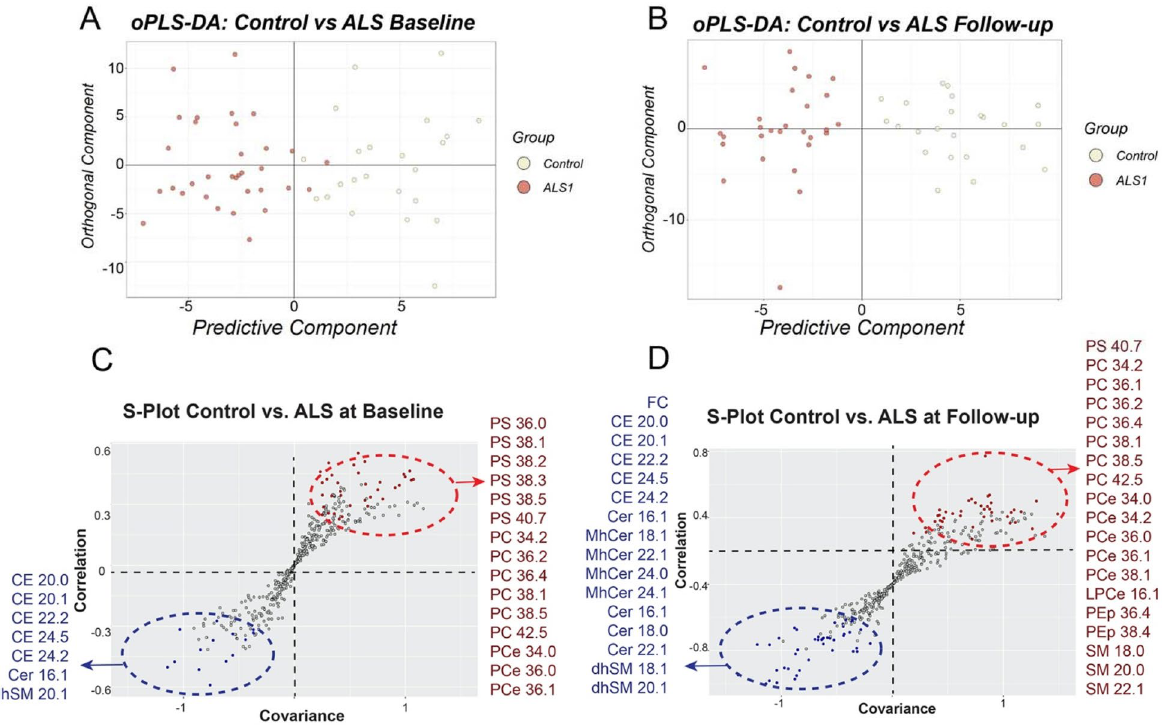
Figure 1. oPLS-DA score plots and corresponding loading S-Plots obtained from control and ( A ) ALS plasma samples at baseline and ( B ) at follow-up. OPLS-DA loadings S-plots indicate significant lipids species between controls and ( C ) ALS at baseline and ( D ) at follow-up times.